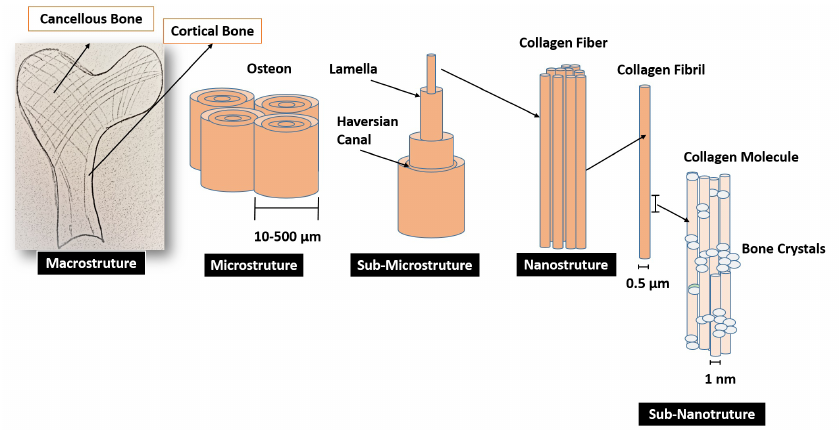
Figure 1. Anatomy of bone. (Adapted of Bao C, Teo E, Chong M., 2013; Clarke B, 2008). Table 1. Properties of cortical and trabecular bones. Type of